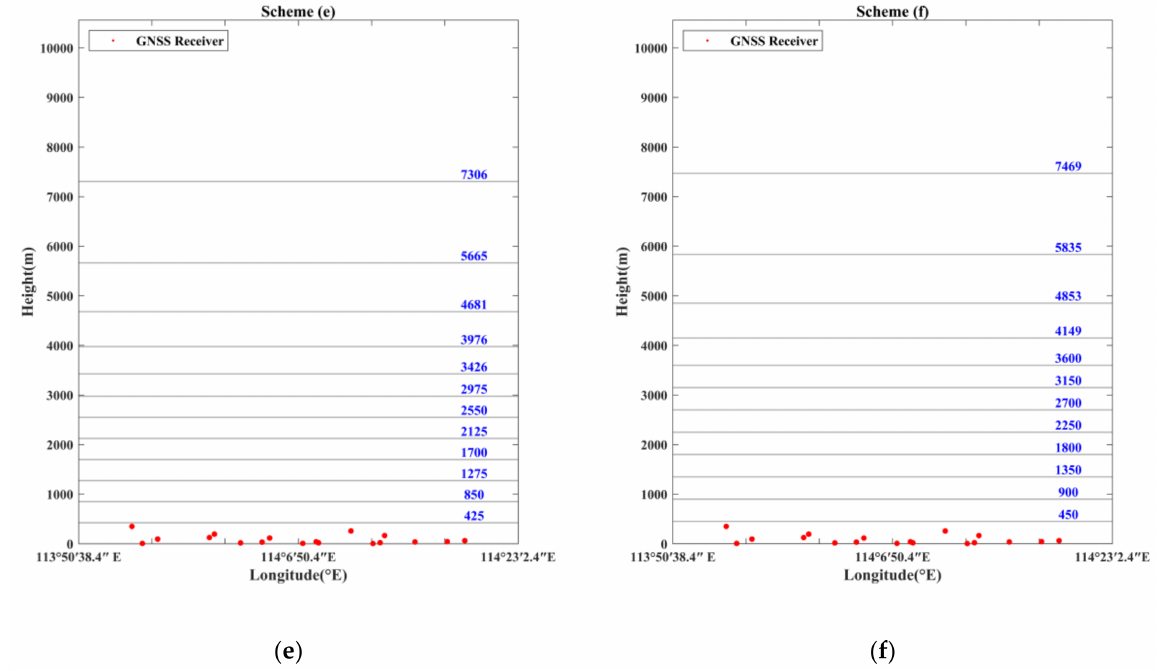
Figure 3. Vertical resolution according to six stratification schemes: ( a ) uniform stratification with height interval of 812 m; ( b ) ANES with minimum height interval of 350 m; ( c ) ANES with minimum height interval of 375 m; ( d ) ANES with minimum height interval of 400 m; ( e ) ANES with minimum height interval of 425 m; ( f ) ANES with minimum height interval of 450 m.